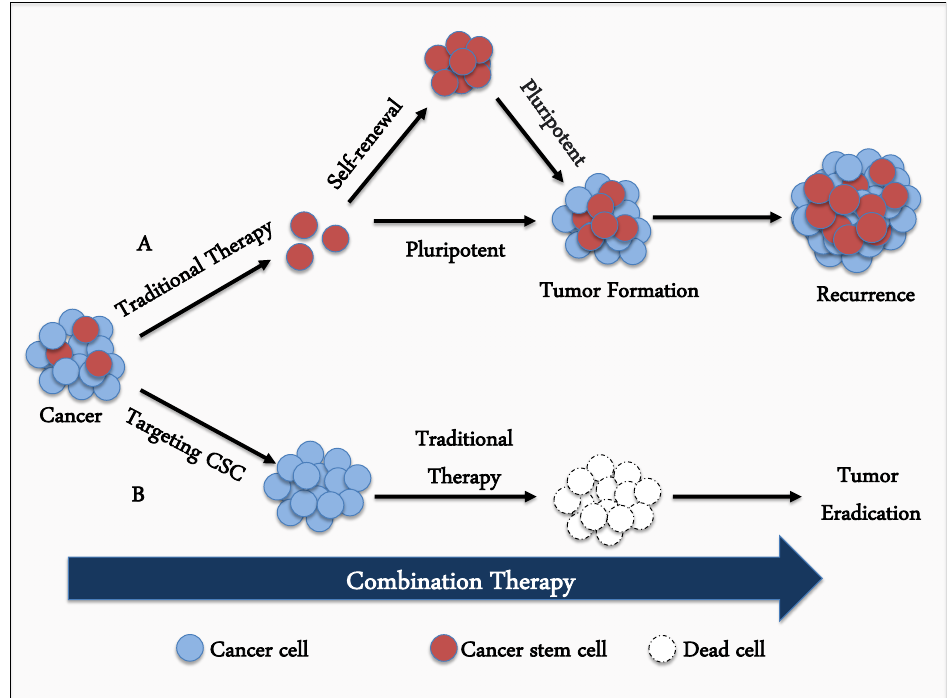
Figure 1. Combination therapy between traditional cytotoxic drugs with cancer stem cell (CSC)- targeting agents. (Path A ) Chemotherapeutic and molecular-targeted drugs can attack most cancer cells, but CSCs can avoid these agents, leading to tumor regrowth. (Path B ) Combination therapy between traditional drugs and CSC-targeting agents is predicted to be more